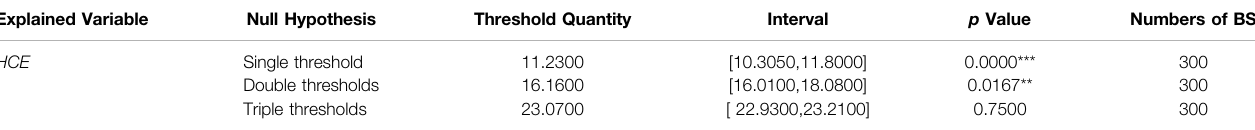
TABLE 5 | Results of threshold test. Explained Variable